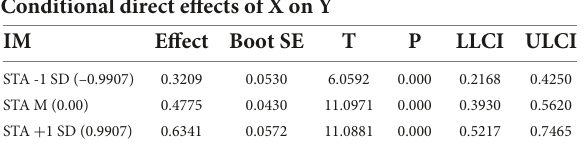
FIGURE2 Interaction